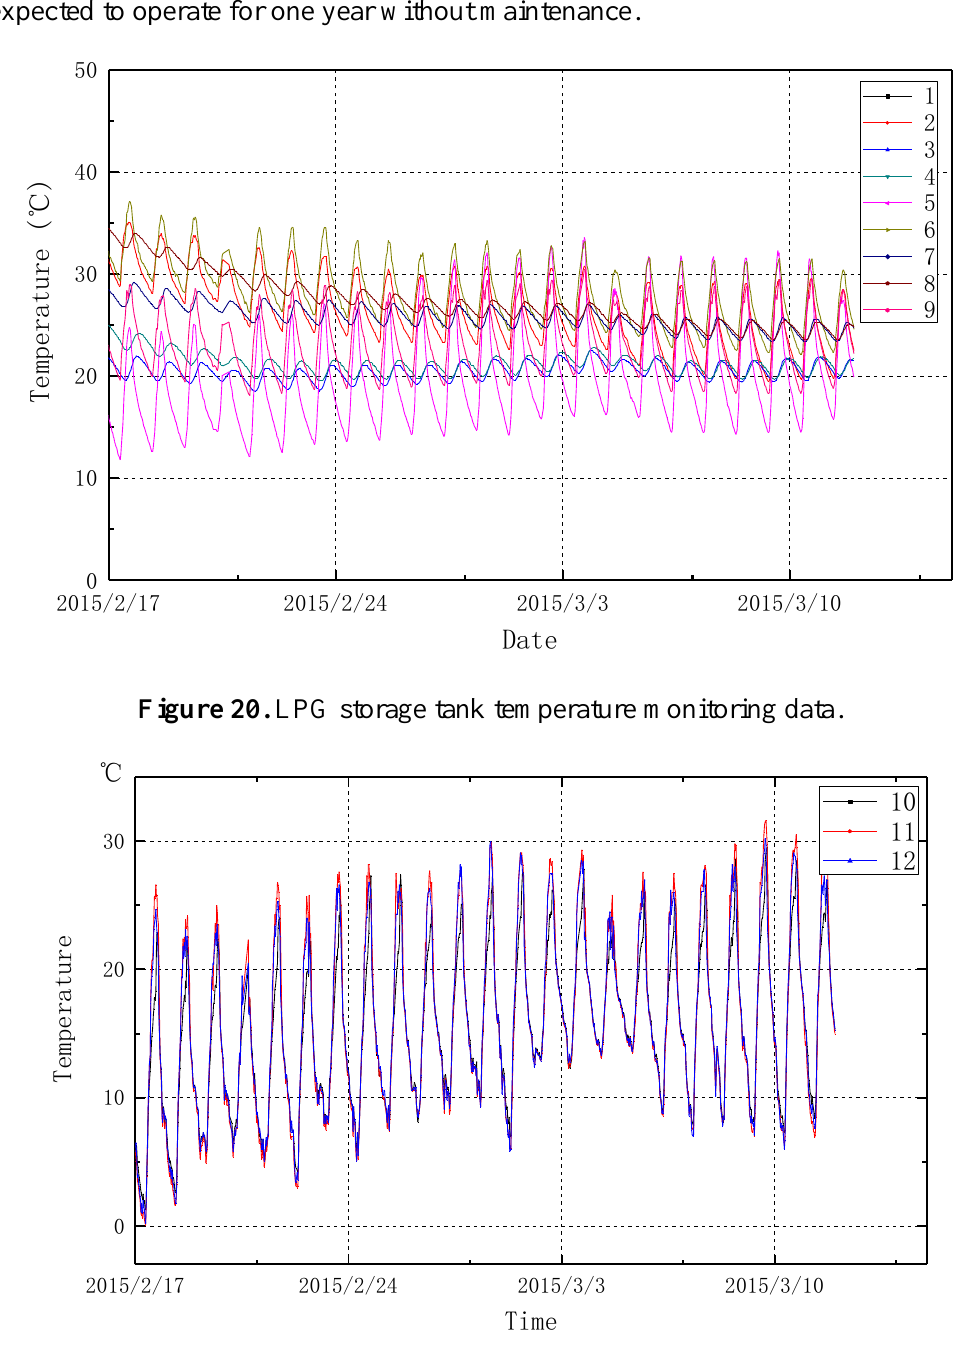
Figure 21. Environment temperature monitoring